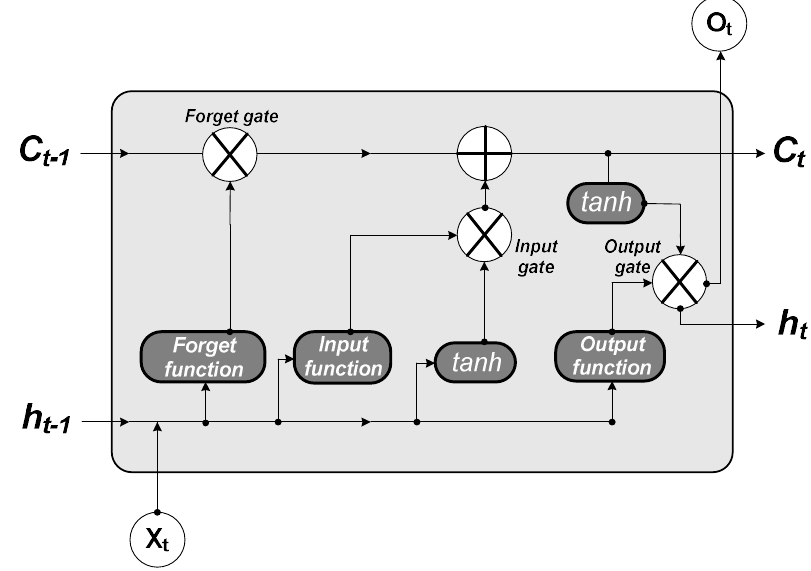
Figure 2. Conceptual diagram of the long short-term memory (LSTM) model.